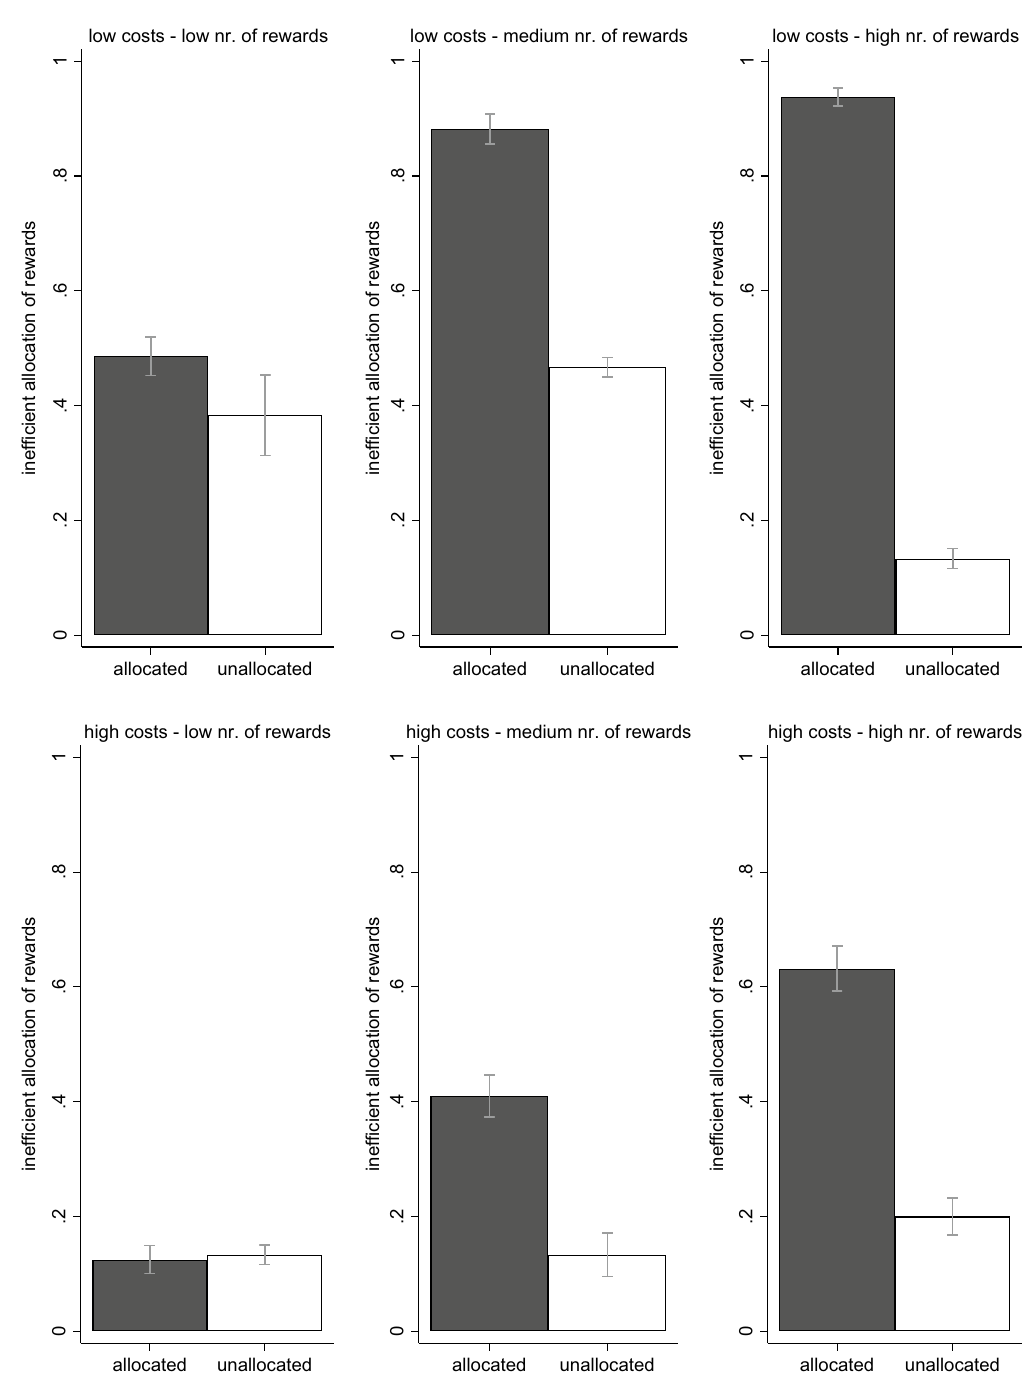
considerably and significantly higher in the allocated condition than in the unallocated condition in most set- tings. Whereas the inefficiency is always below 50% in the unallocated condition, it is above 50% in half of the settings in the allocated condition. The observed competition rates are thus relatively efficient for the unallocated condition and largely inefficient for the allocated condition. Note that a reverse pattern could in theory also have been possible. Had most participants abstained from competition in both conditions, then inefficiency would have been higher in the unallocated condition than in the allocated condition. Such inefficiently low competition